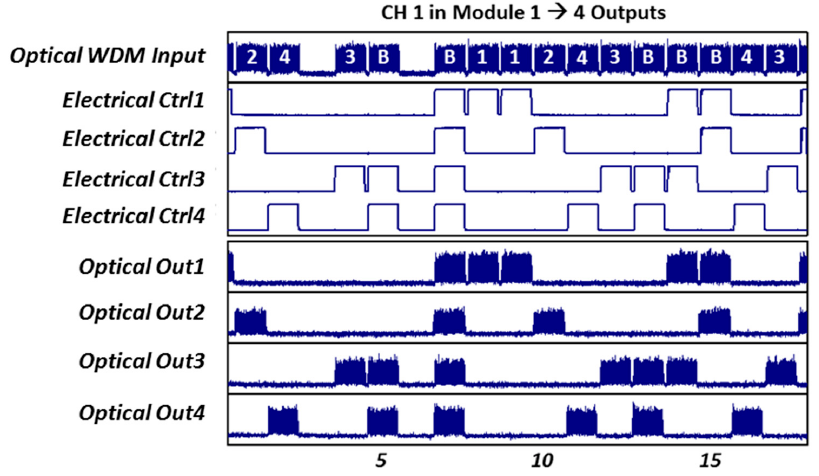
Figure 10. Traces for Channel 1 in Module 1 destined to four outputs.